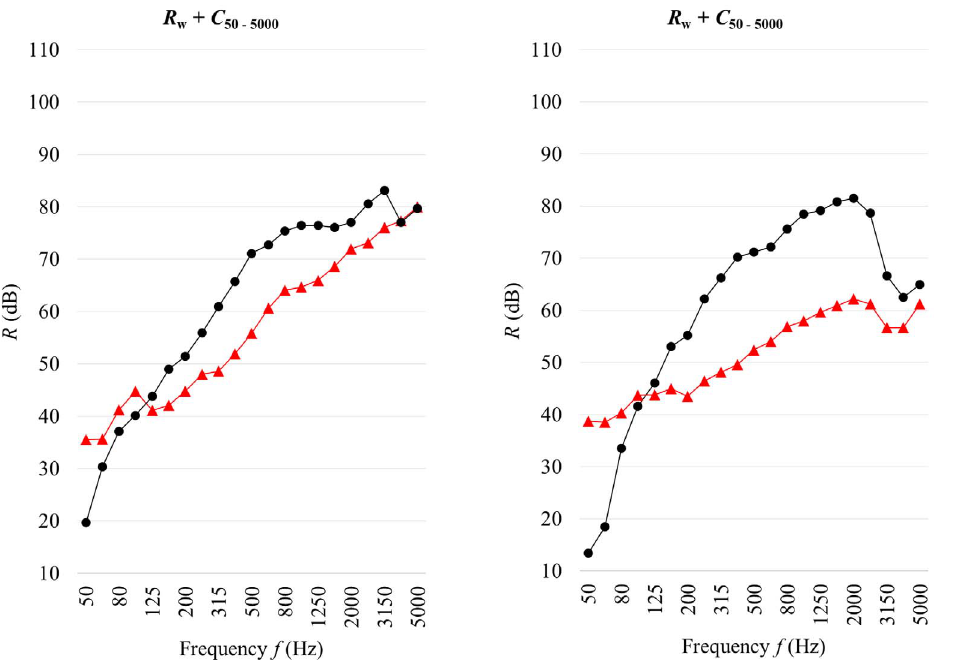
Figure A1. Left : spectra of 2 walls with equal R w + C 50 – 5000 SNQ value (58 dB): wall “ 21_HW_59 ” N = 0.205 sone (red curve with triangles), wall “ 30_LW_66 ” , N = 0.111 sone (black curve with dots). Right : spectra of 2 walls with very similar transmitted Loudness values: wall “ 36_LW_69 ” , R w + C 50 – 5000 = 52 dB, N = 0.393 sone (black curve with dots), wall “ 17_HW_56 ” , R w + C 50 – 5000 = 55 dB, N = 0.402 sone (red curve with triangles). The mentioned Loudness values ( N ) are based on emitted pink noise on the sending